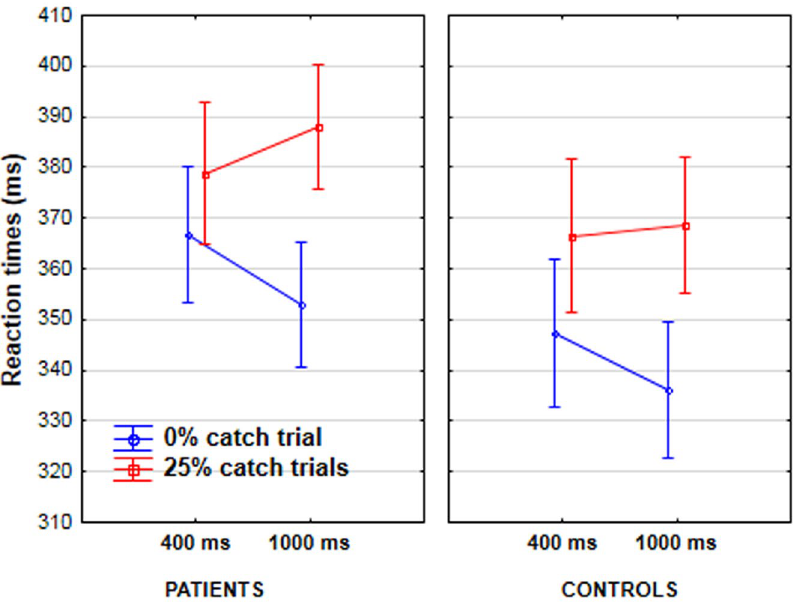
Figure 1. Reaction times in patients (lefthand graph) and controls (righthand graph) as a function of target condition (0% catch trial in blue, vs. 25% catch trials in red), and the foreperiod between the cue and the target (400 vs. 1000